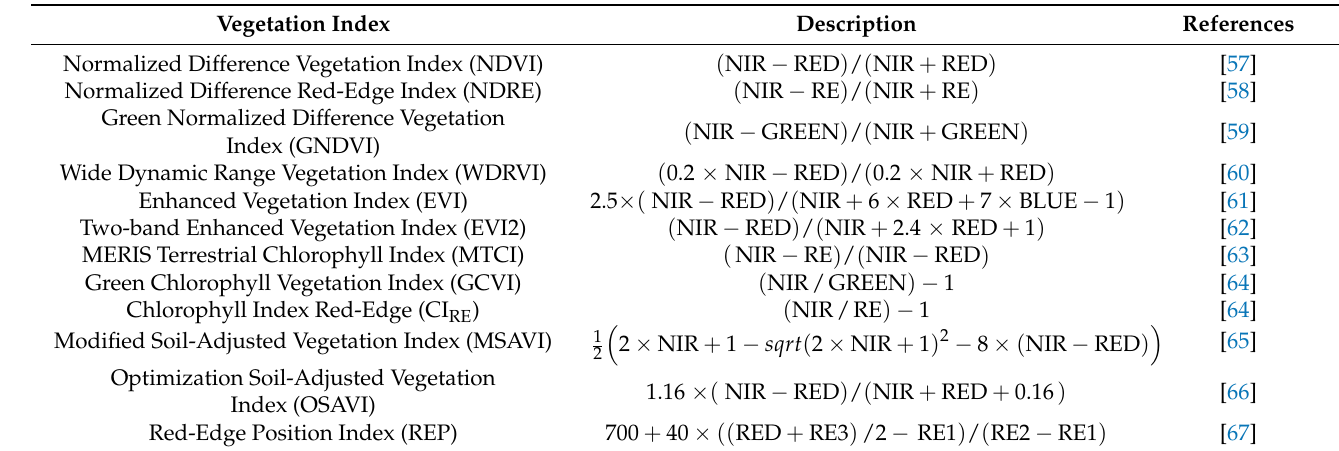
Table 4. Initial vegetation index